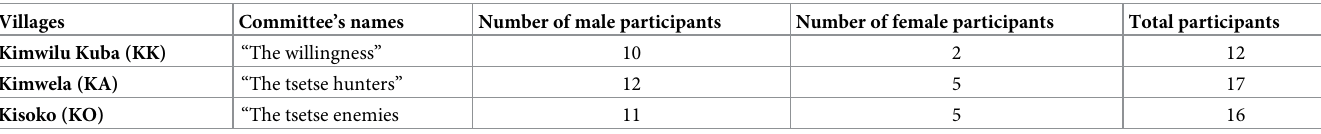
Table 3. Gender representation amongst committee